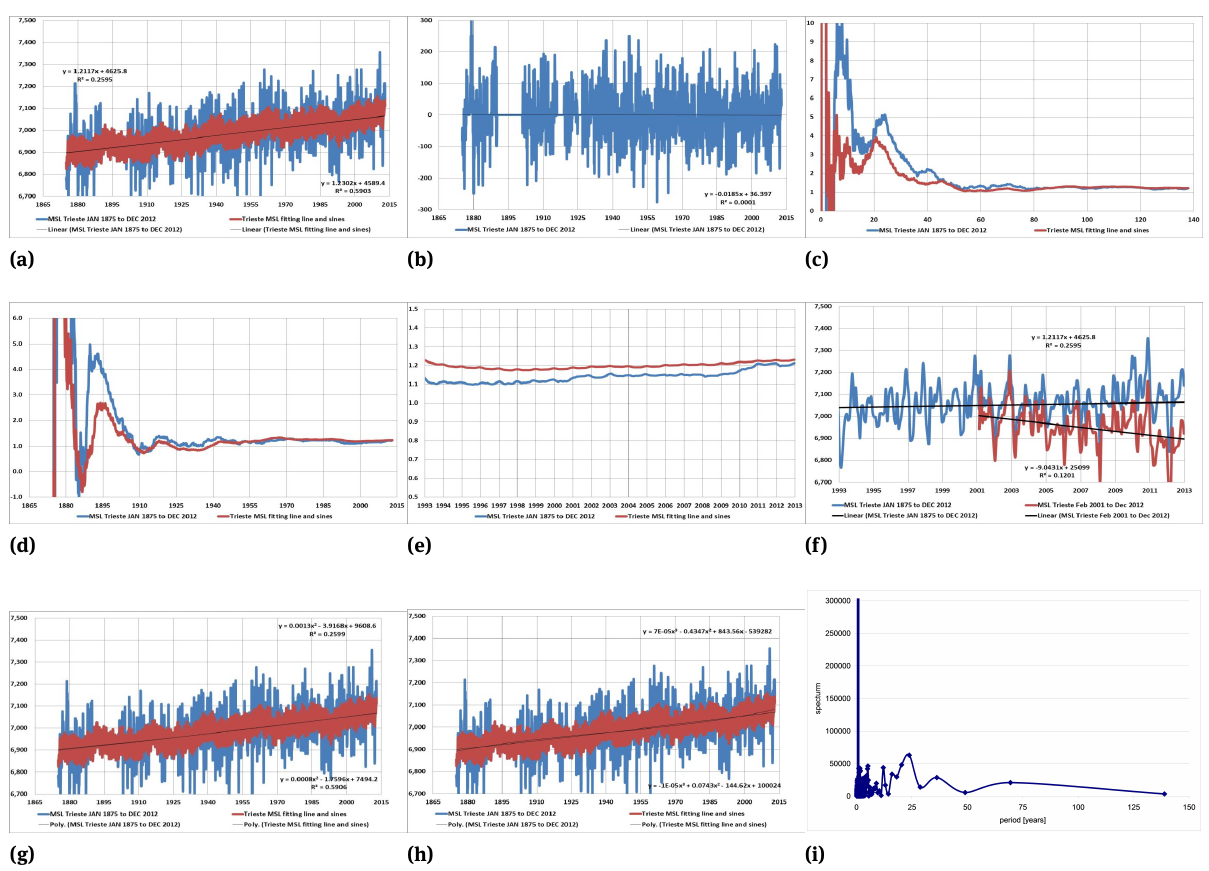
Fig. 4. Trieste tide gauge results: a) is the measured MSL with gaps filled and fitting with a line and sines. b) is the residual of the fitting with a line and sines. c) is the present rate of rise of sea level by using different record length. d) is the time history of the rate of rise from all the data up to a specific time. e) is the same of d) with zoom on the last two decades of the satellite altimetry. f) is the measured MSL of the historical and recent stations; g) is the parabolic fitting of the measured MSL with gaps filled; h) is the cubic fitting of the measured MSL with gaps filled; i) raw periodogram of the monthly average mean sea level results with gaps